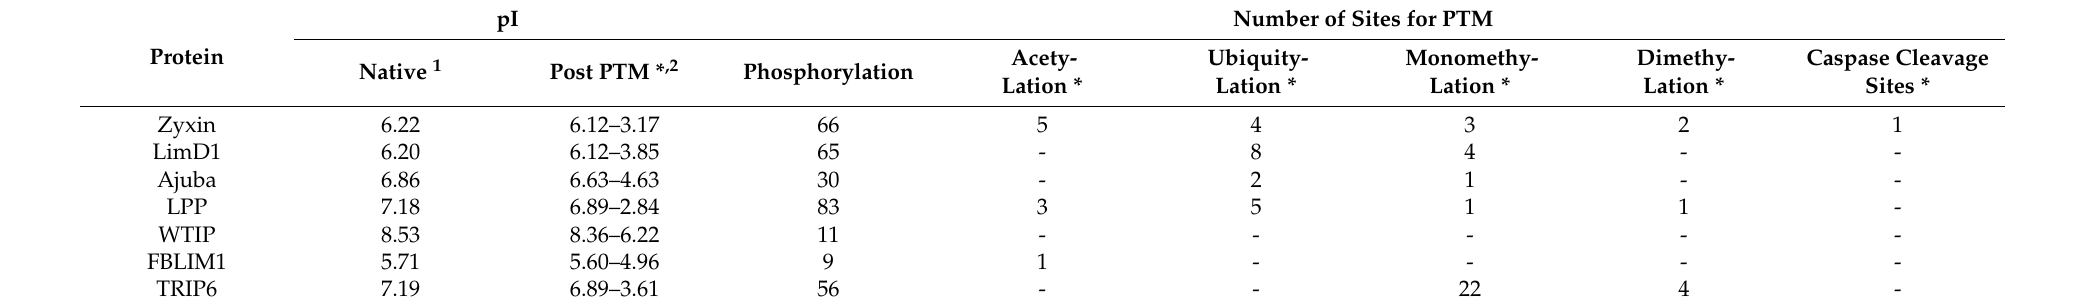
Table 3. Effect of post-translational modifications on isoelectric point of Zyxin family